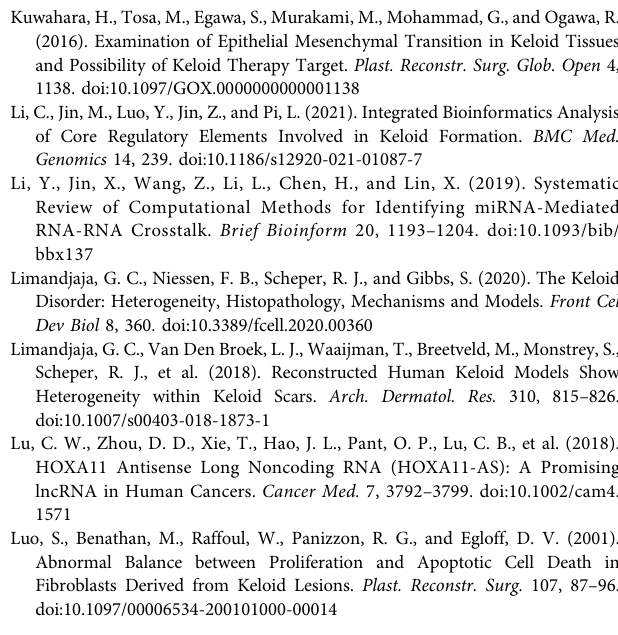
Supplementary Figure S1 | Signi fi cantly downregulated HOXA11-AS in keloid fi broblasts with HOXA11-AS knockdown comparing to keloid fi broblasts without HOXA11-AS knockdown via qPCR. Supplementary Figure S2 | Comparison of dynamic expression of Ki-67 in three passages ofkeloid fi broblasts between central regions and peripheral regionswithin excised keloid